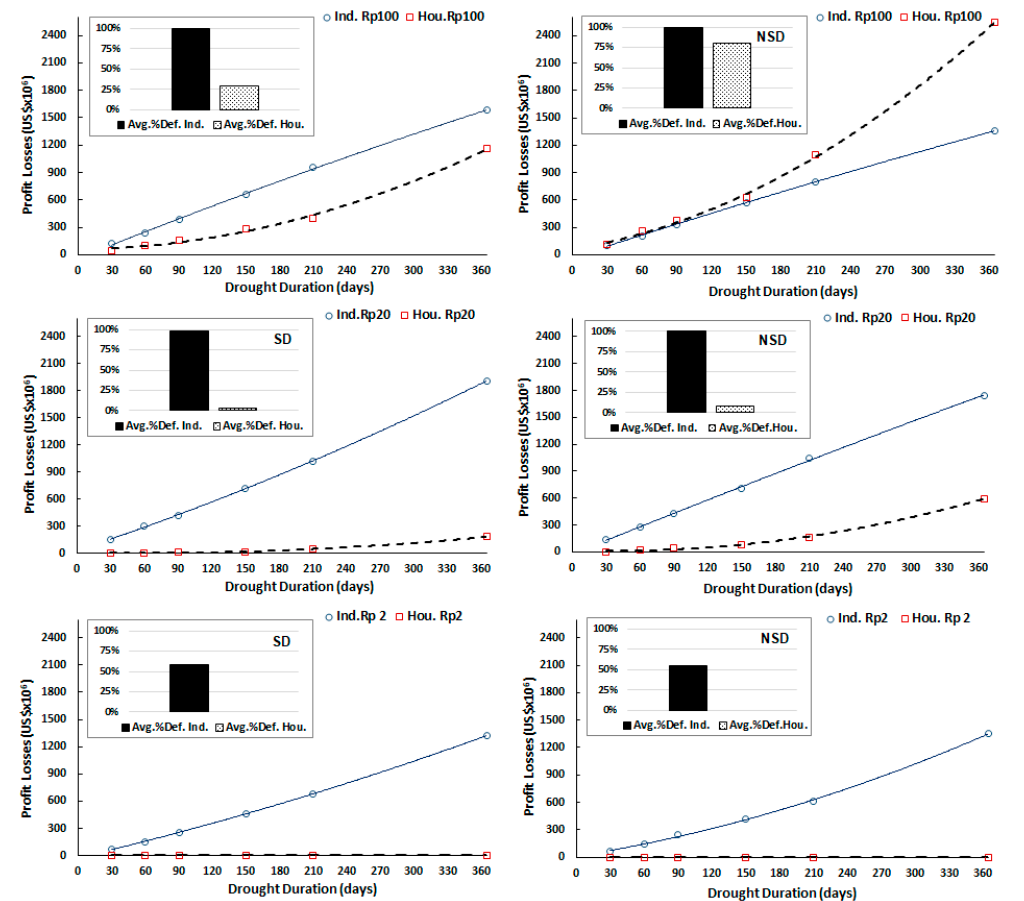
Figure 5. Relationships of profit loss derived from 360-day continuous drought per sector—industrial (Ind., continuous line) and household (Hou., dashed line). From top to bottom: return period (Rp) from 100, 20, and 2 years under water demand scenarios of stationary demand (SD = 31 m 3 s − 1 ) and non-stationary demand (NSD = 24–36 m 3 s − 1 ).